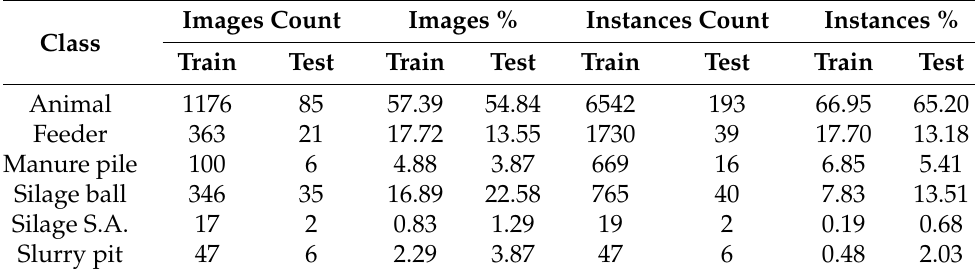
Table 4. Train and test division used in all object detectors